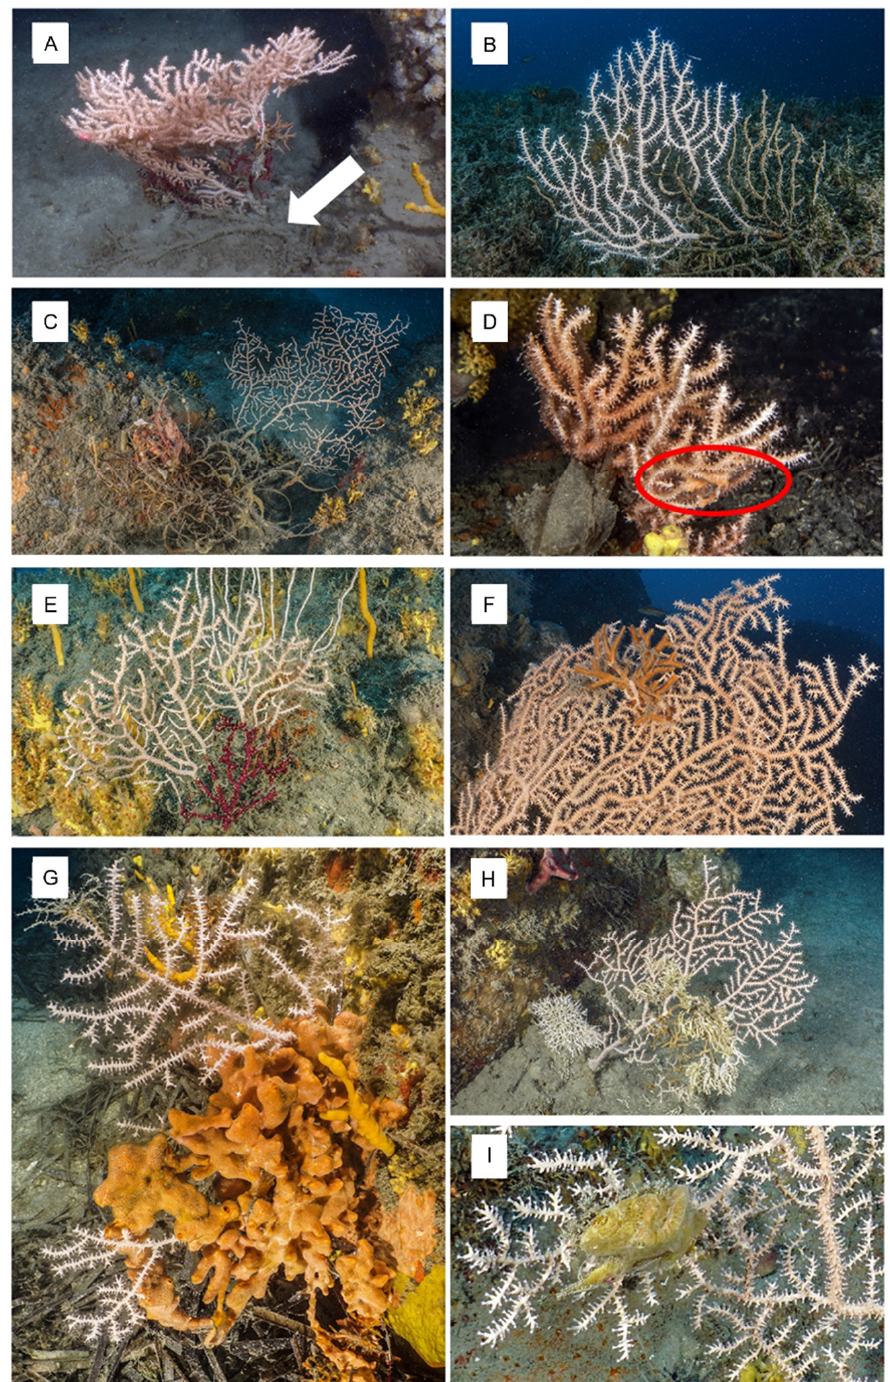
Figure 5. Examples of mechanical damages and epibiosis affecting E. verrucosa . ( A ) dead colony (white arrow); ( B ) a colony with a huge portion deprived by coenenchyme; ( C ) colonies entangled with an abandoned line and plastic debris ( D ) Red circle refers to spawning polyps; ( E – H ) main epibionts affecting E. verrucosa : the parasitic octocoral Alcyonium coralloides ( E ) the bryozoans Turbi- cellepora avicualaris , ( F ) Adeonella calveti , with the sponge Crella elegans , ( G ) the Salmacina / Filograna complex ( H ) and ( I ) the bivalve Pteria hirundo .